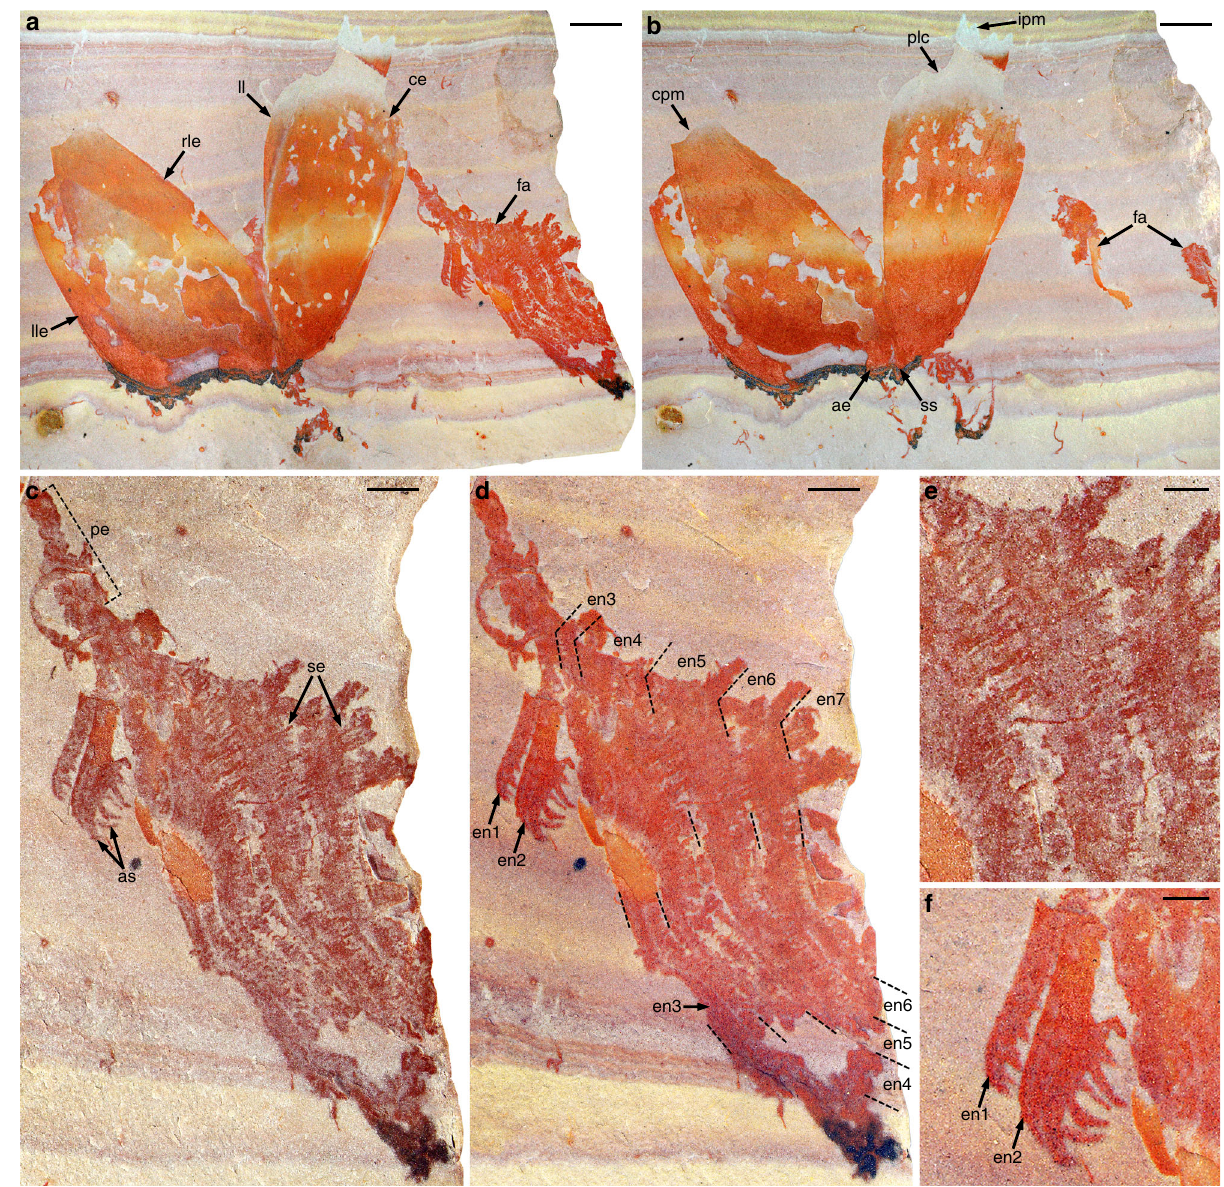
Fig. 1 Assemblage of cephalic elements of Pahvantia hastata . Photographs of part and counterpart of specimen KUMIP314089 immersed in dilute ethanol ( a , b , d , f ) or dry ( c , e ). a , b General views of part ( a ) and counterpart ( b ). c – f Details of the frontal appendage ( c , d ), its setae ( e ), and its proximalmost two endites ( f ). Scale bars represent 5 mm ( a , b ), 2 mm ( c , d ), 1 mm ( e , f ). ae anterior extension, as auxiliary spines, ce central element, cpm concave posterior margin, en1 – 7 endites 1 – 7, fa frontal appendage, ipm indented posterior margin, ll lateral lip, lle left lateral element, pe peduncle, plc postero- lateral constriction, rle right lateral element, se setae, ss anterior sagittal